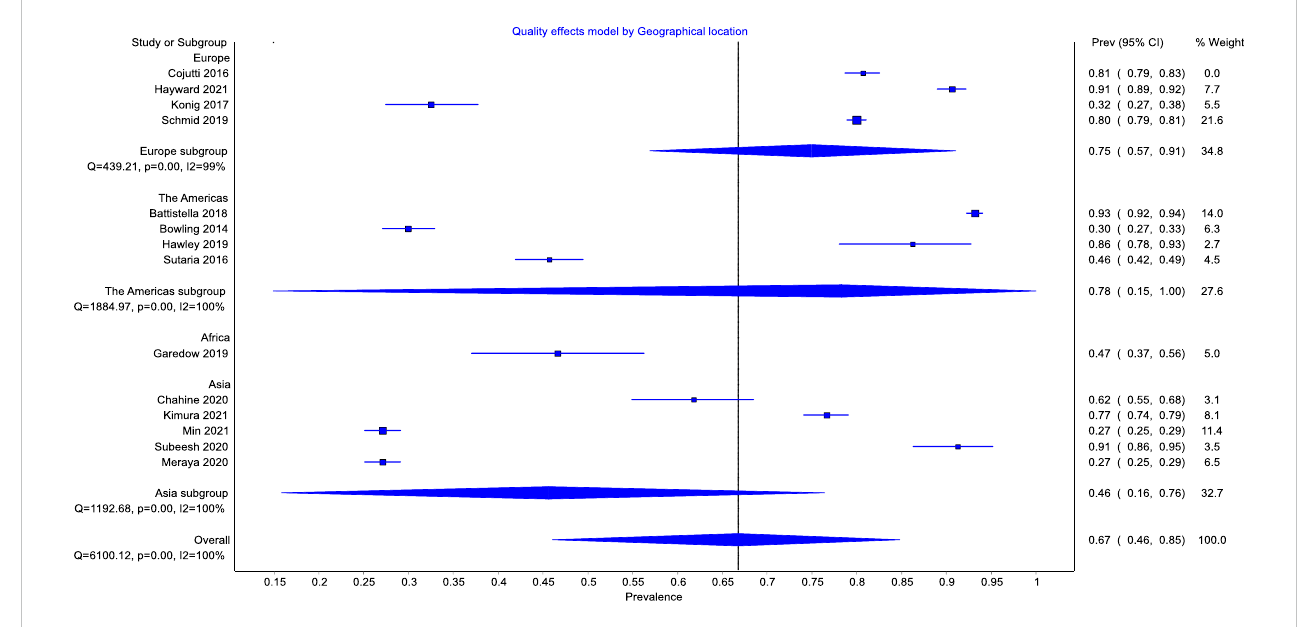
FIGURE 5 Forest plot of the prevalence of polypharmacy among patient with CKD across